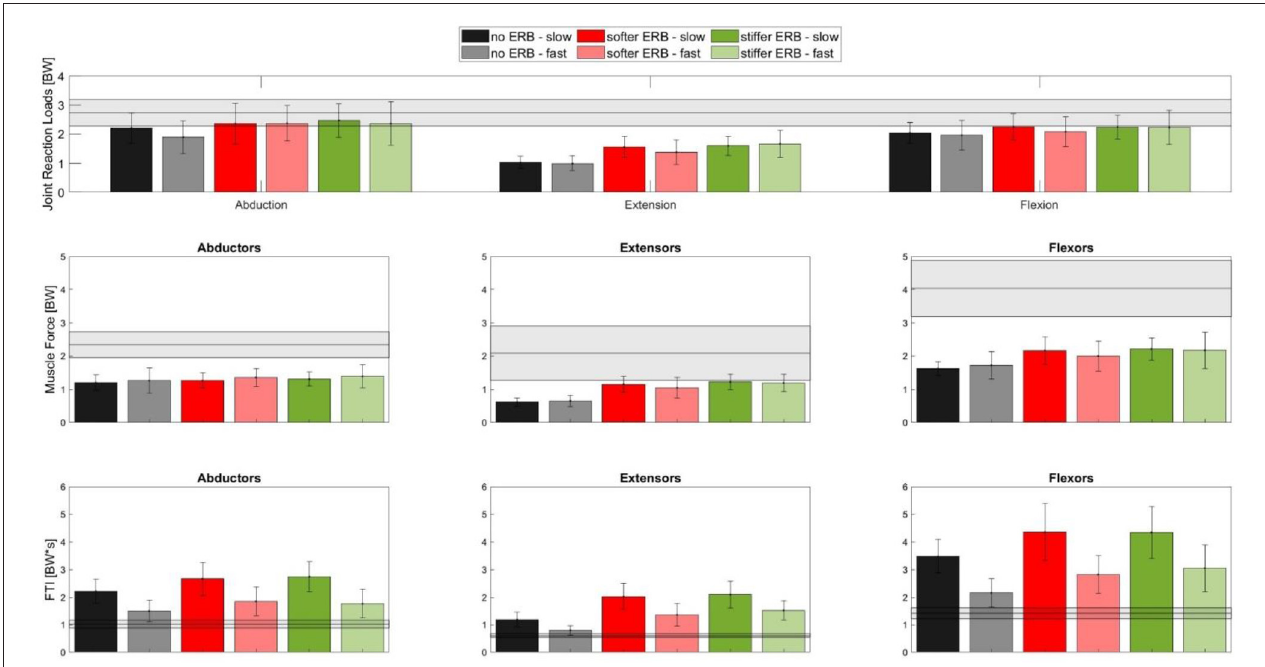
FIGURE 7 | Bar plots showing the mean ( ± SD) of the peak HJCF (top row) during abduction (left), extension (middle), and flexion (right) as well as the peak muscle forces (middle row) and FTI (bottom row) of the respective target muscle groups (abductors, extensors, and flexors, shown in the left, middle, and right sides, respectively) in the movement leg. Each bar represents one of the execution variants (see the legend above). The gray horizontal bar in every plot depicts the mean ( ± SD) values of the respective parameter measured during a gait